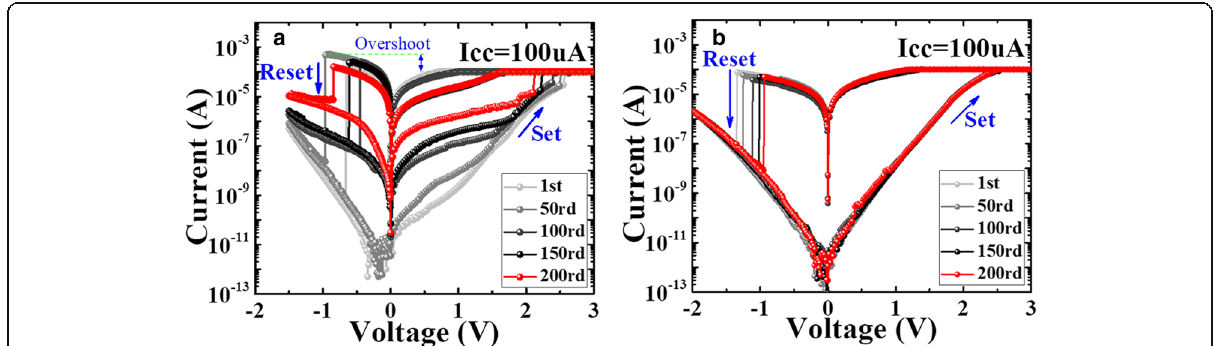
Fig. 2 Typical I-V curves of Cu/TaOx/W devices before annealing ( a ) and after annealing ( b ) with 200 cycles